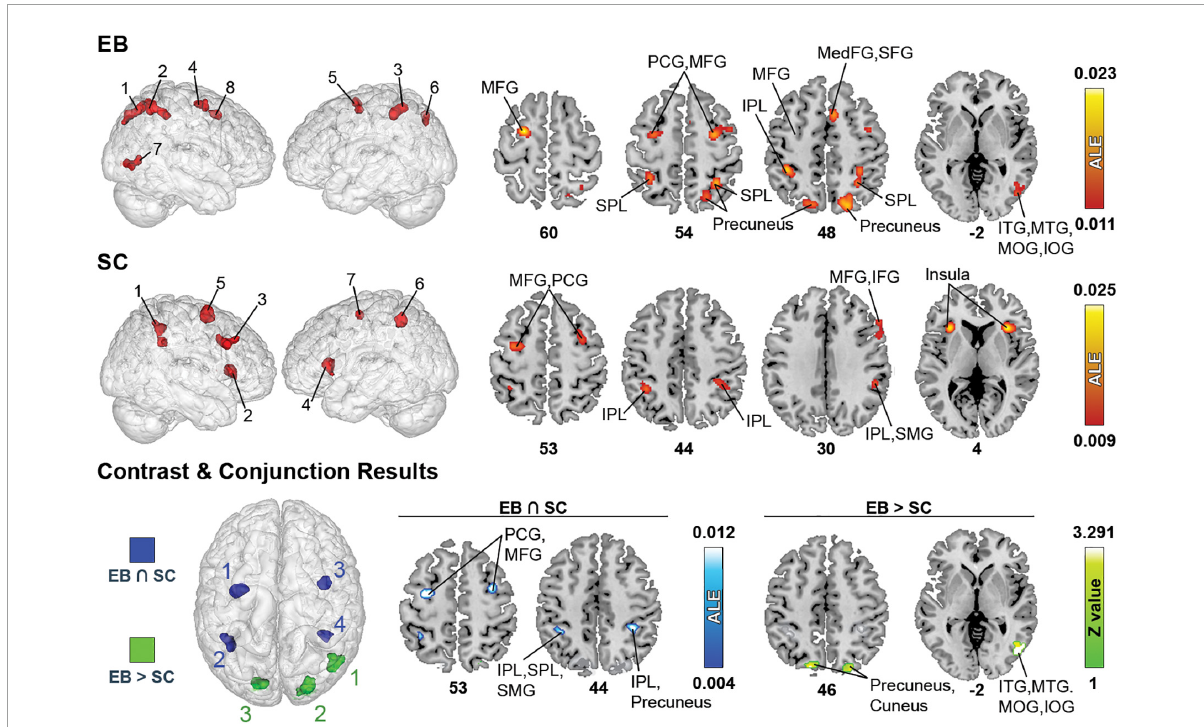
FIGURE2 Brain areas activated by spatial processing in EB and SC and results of contrast and conjunction analyses. (Left) 3D renders of the brain and activation clusters (see Table 4 for reference). (Right) Axial cuts of the brain with identified clusters of activation. The number below the slices refer to the z coordinate in MNI space. ALE (for single and conjunction meta-analyses) and Z values (for contrast meta-analyses) are displayed to the right. The ALE values, calculated for each voxel, represent the probability of activation across included studies (Turkeltaub et al., 2012). For the contrast analysis, Z-values show the significance of ALE subtractions between two groups. More details regarding the ALE and Z values are presented in Table 3 . IOG, inferior occipital gyrus; IPL, inferior parietal lobule; ITG, inferior temporal gyrus; MedFG, medial frontal gyrus; MFG, middle frontal gyrus; MTG, medial temporal gyrus; PCG, precentral gyrus; SFG, superior frontal gyrus; SMG, supramarginal gyrus; SPL, superior parietal